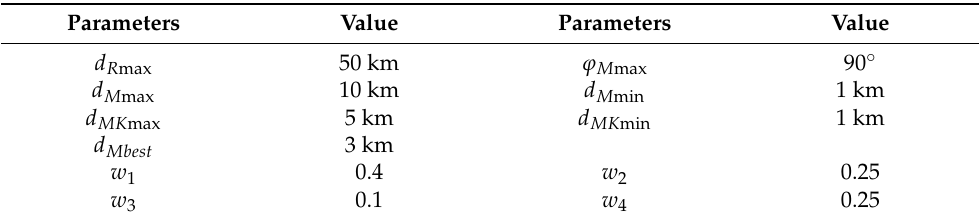
Table 2. Simulation